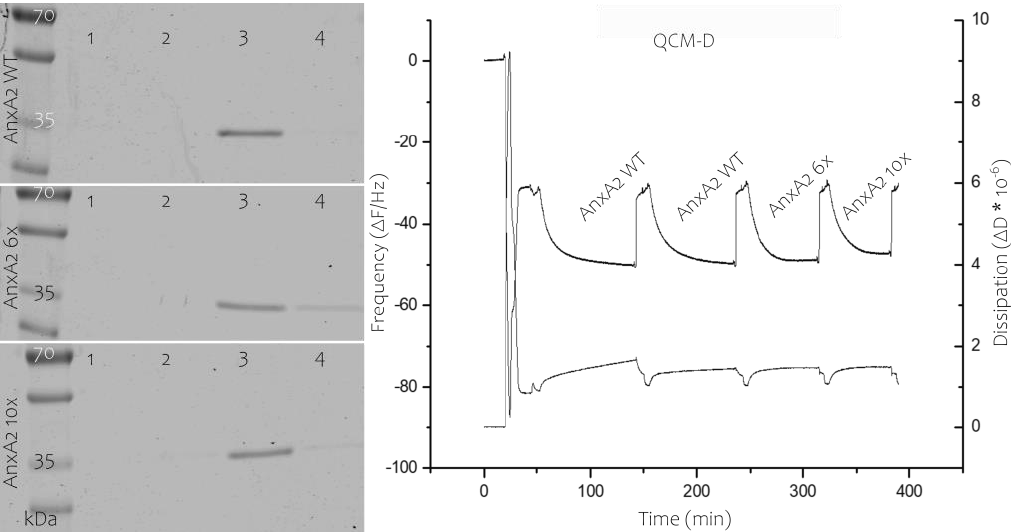
Figure 4. Membrane binding of AnxA2 constructs. Left, Liposome co-pelleting assay analyzed by SDS-PAGE of the di ff erent fractions. AnxA2 wild-type (WT), AnxA2 6x, or AnxA2 10x were mixed with PS-containing liposomes in the presence of 1 mM Ca 2 + . Liposomes were pelleted and the supernatant, i.e., non-bound material, was collected (lane 1). Liposomes were then washed in Ca 2 + -containing bu ff er, yielding a second supernatant (Ca 2 + wash, lane 2). Subsequently, the pelleted liposomes were washed with EGTA-containing bu ff er resulting in release of the Ca 2 + -dependently bound material (EGTA eluate, lane 3). The final liposome pellet containing non-released protein is shown in lane 4. The gel shows a representative result of n = 5 independently performed experiments. Right, QCM-D measurements, frequency (as deviation from resonance frequency, ∆ F) is shown in the upper recordings and dissipation ( ∆ D) in the lower. Following formation of a solid-supported bilayer (at a ∆ F of around − 30 Hz in these settings), AnxA2 WT was added in the presence of Ca 2 + , resulting in a drop in resonance frequency to approximately − 49 Hz. Addition of EGTA removed all bound protein with resonance frequency returning to its initial bilayer value ( − 30 Hz). Recording was continued with subsequent additions (in Ca 2 + containing bu ff er) and release (in EGTA containing bu ff er) of AnxA2 WT (to show reversibility of the reaction), AnxA2 6x, and AnxA2 10x. The QCM-D recordings were performed at least three times each for the di ff erent, independently purified AnxA2 derivatives.